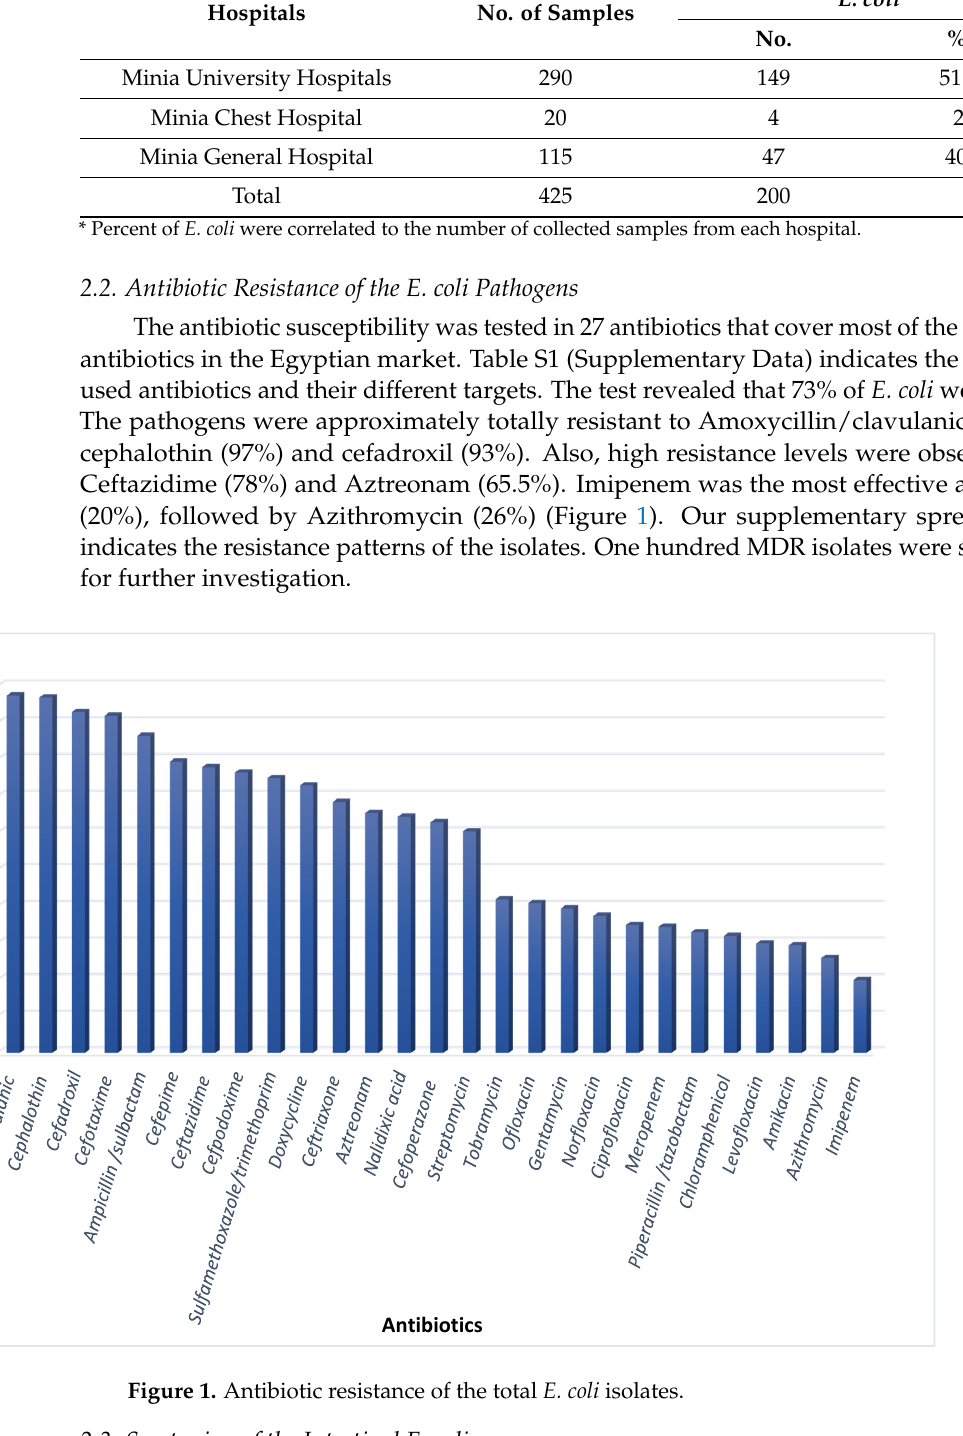
Table 2. Distribution of E. coli among samples collected from different hospitals.